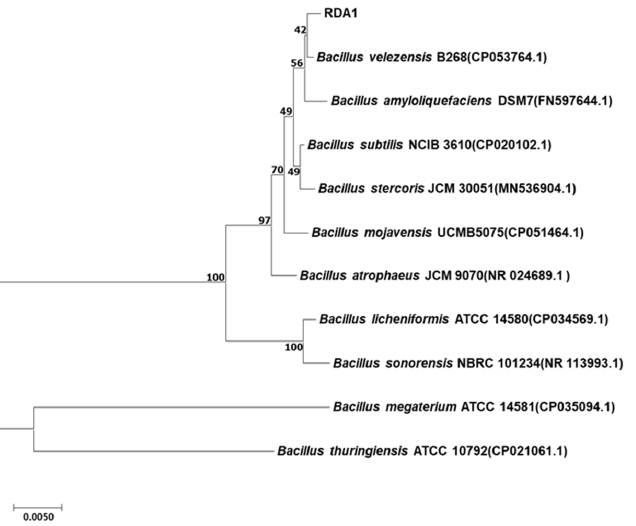
Figure 1. 16S rDNA phylogenetic tree showing the relationship between the strain RDA1 and other Bacillus sp. strains. The tree was constructed using the neighbor-joining method via the MEGA X program. Kimura-2 parameter was used as the nucleotide substitution model. The bootstrap values (%) presented at the branches were calculated from 1000 replications. Bacillus thuringiensis ATCC 10792 (CP021061.1) was used as an out-group. The scale bar indicates 0.005 substitutions per nucle- otide position. 2.2. In Vitro Antifungal Efficacy of RDA1 against R. necatrix The in vitro antagonistic efficacy of RDA1 against R. necatrix was assessed using di- rect confrontation assays (dual-culture plates). The inhibition zones of the pathogenic fungi were measured as percentages on PDA plates. RDA1 showed high inhibitory activ- ity against R. necatrix (KACC 40168, 40445, 40446, and 40447) (Figure 2a). The highest level of fungal growth suppression was 81.57 ± 4.86% against KACC 40447, followed by 77.53 ± 2.88%, 76.72 ± 4.97%, and 75.67 ± 4.72% against KACC 40445, KACC 40168, and KACC 40446, respectively (Figure 2b). These strong antifungal activities may be attributed to cer- tain diffusible compounds, such as antibiotics, against R. necatrix